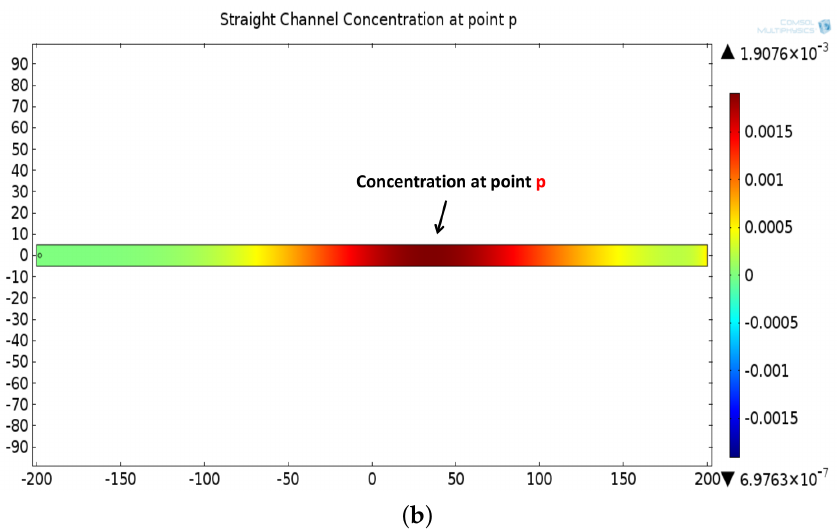
Figure 8. ( a ) Degraded concentration signal at the point p in a straight channel, temporally spread and attenuated signal. ( b ) Two-dimensional surface plot showing concentration profile at point p in a straight channel.